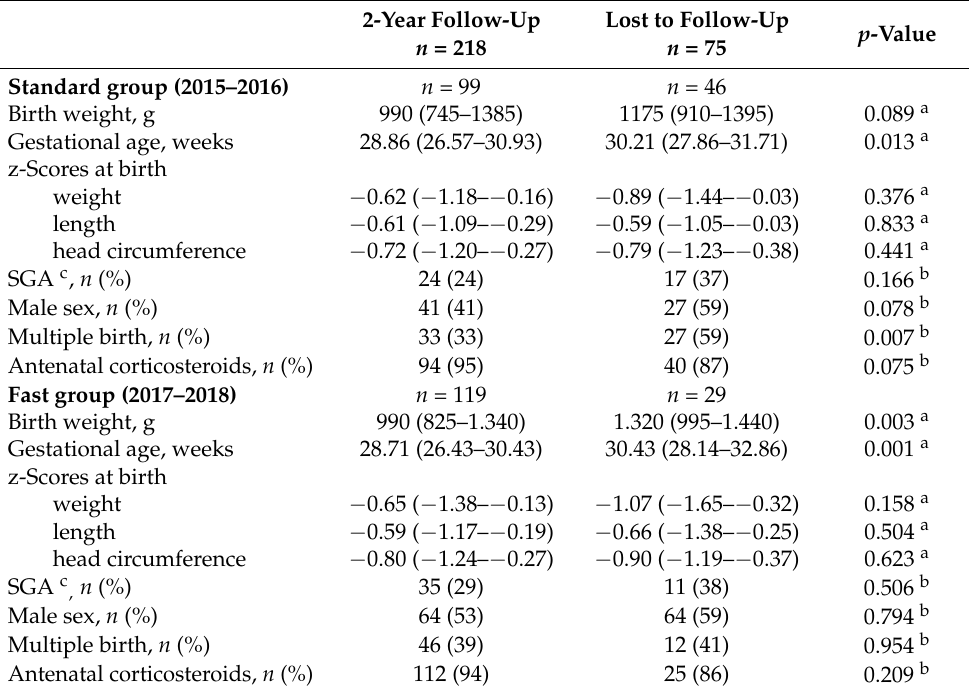
Table 2. Demographics and characteristics of the lost to follow-up collective vs. follow-up